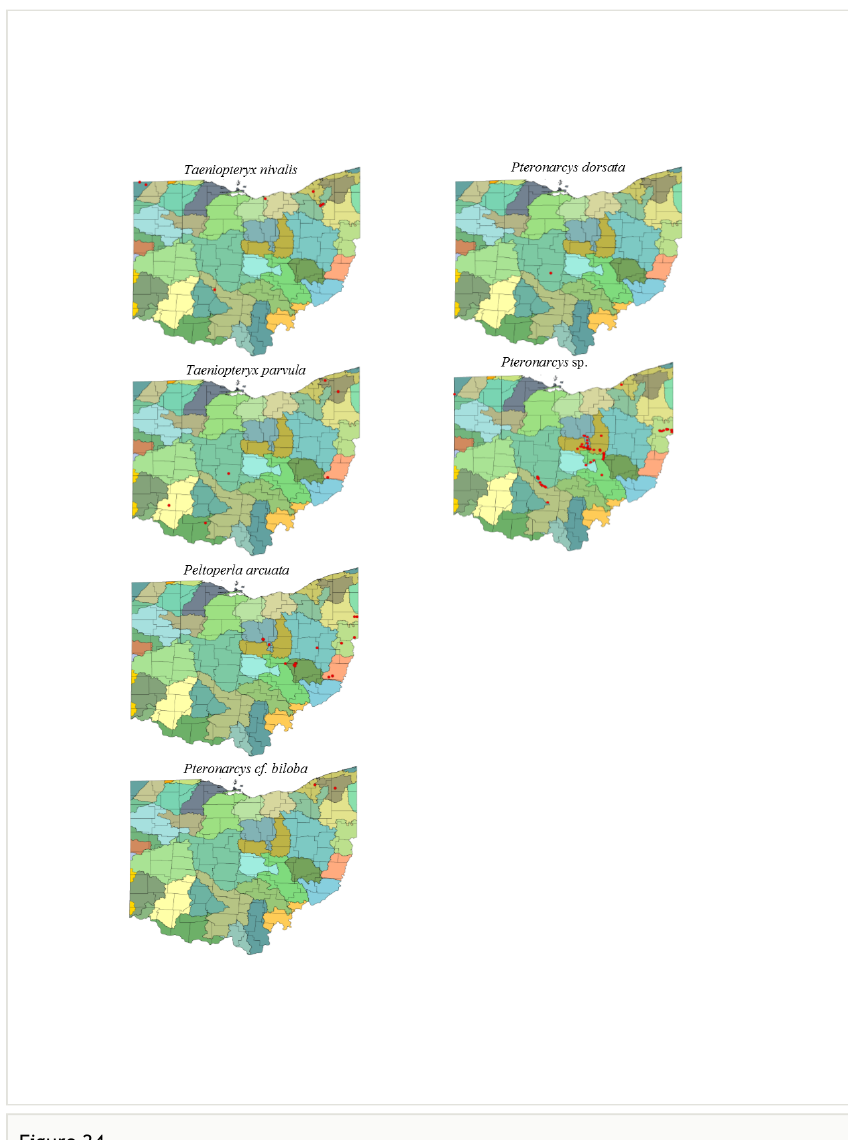
Figure 24. Distribution of Taeniopterygidae, Peltoperlidae, and Pteronarcyidae in